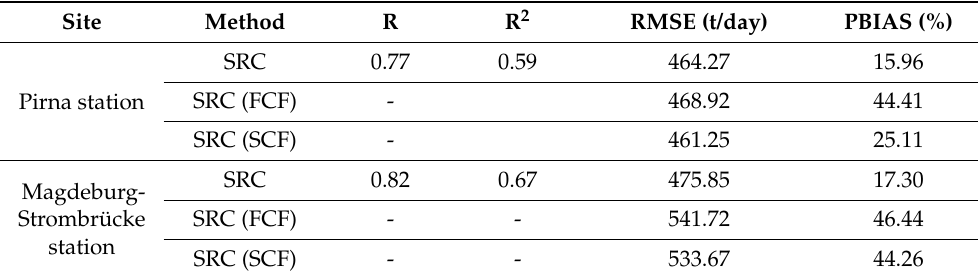
Table 5. The performance evaluation of the SRC approaches.